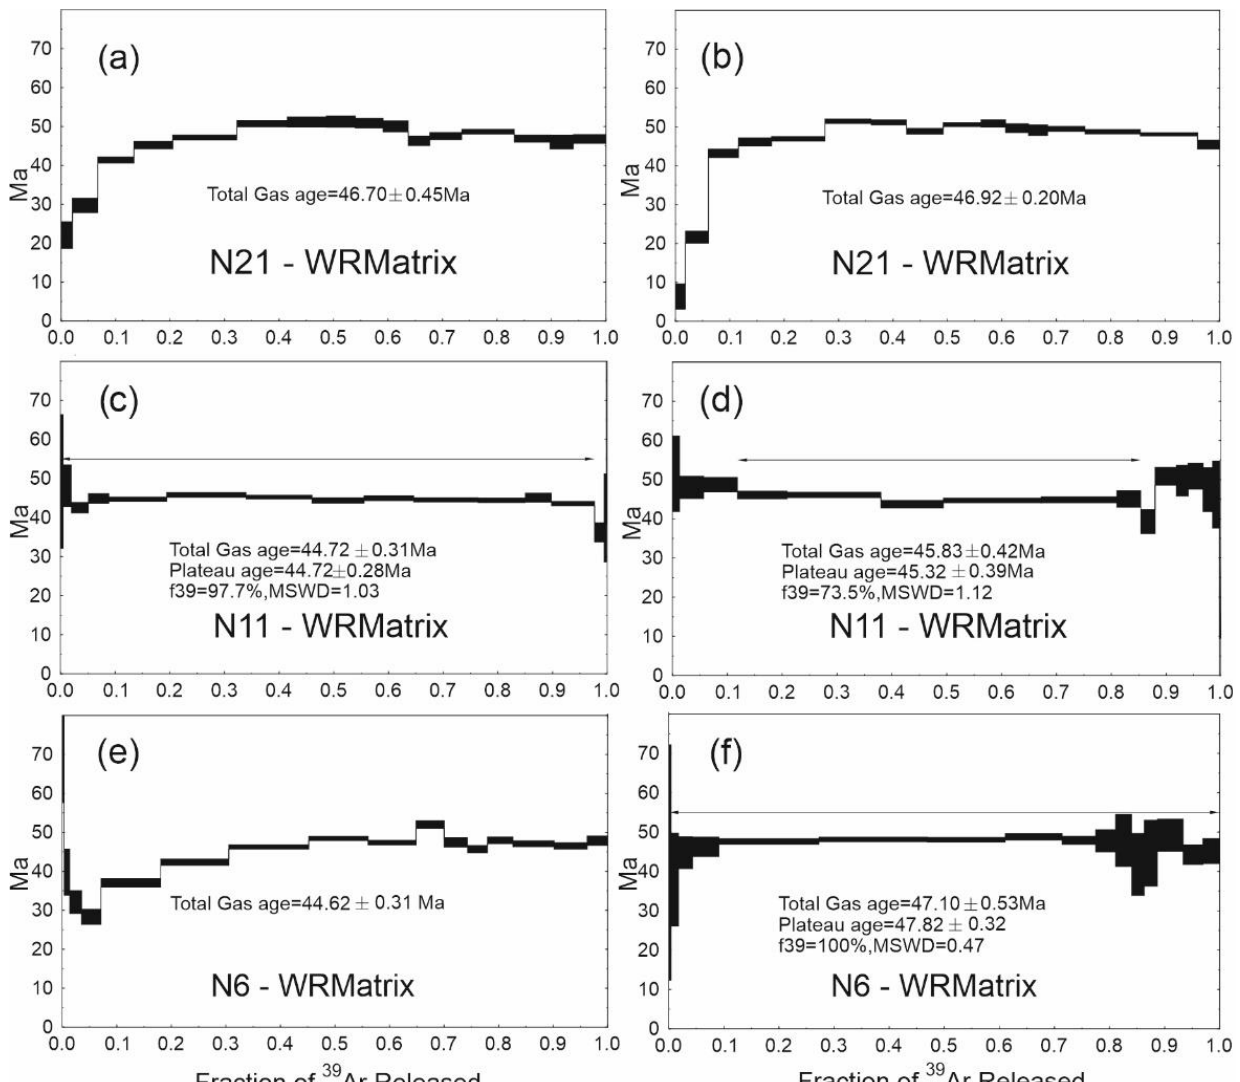
Figure 5. (a – f) 40 Ar – 39 Ar age spectra and plateau ages of basaltic units (V1 unit) of SNV. Figure 5. ( a – f ) 40 Ar– 39 Ar age spectra and plateau ages of basaltic units (V1 unit) of